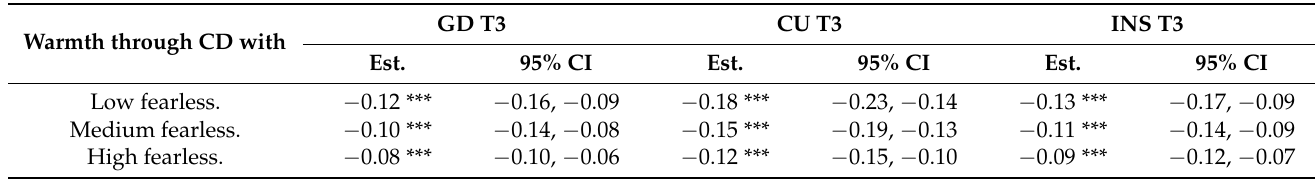
Table 3. Unstandardized indirect mediation effects of parental warmth (T1) on psychopathic traits (T3) through conscience development (T2) moderated by the level of fearlessness (T1). GD T3 CU T3 INS T3 Warmth through CD with Est. 95% CI Est. 95% CI Est. 95% CI Low fearless. − 0.12 *** − 0.16, − 0.09 − 0.13 *** − 0.17, − 0.09 Medium